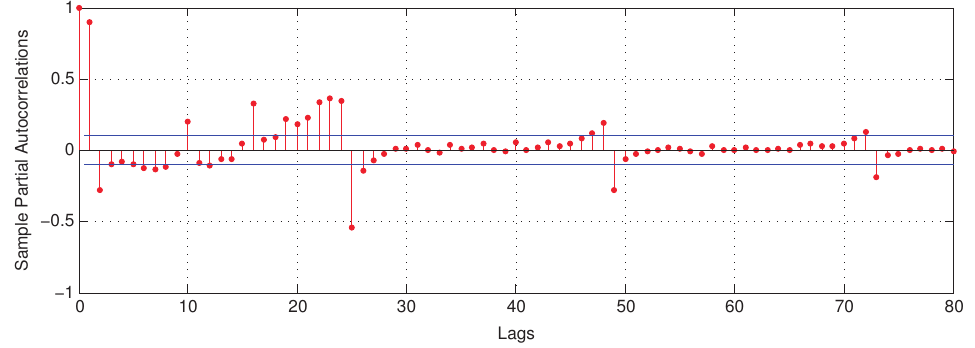
Figure 10. The partial autocorrelation function (PACF) of the 60-min prediction experiment with 80 lags.